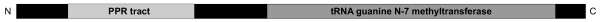
Conserved domain architecture of PPR-TGM proteins. Each protein has a PPR tract consisting of 3–7 PPR motifs and a C-terminal tRNA guanine N-7 methyltransferase domain. Additionally, some PPR-TGM proteins contain N-terminal signal peptides (not shown).